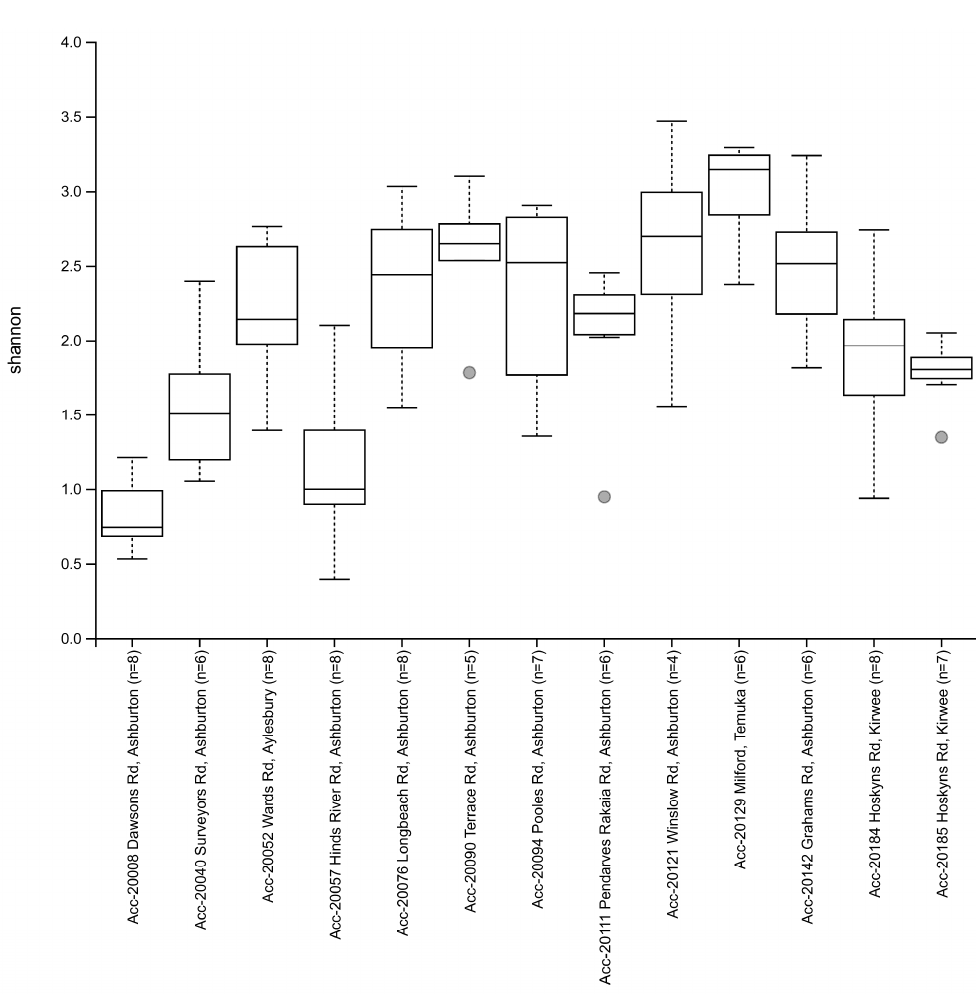
Figure 5. Estimated Shannon alpha diversity indexes between Biogeography Seed.